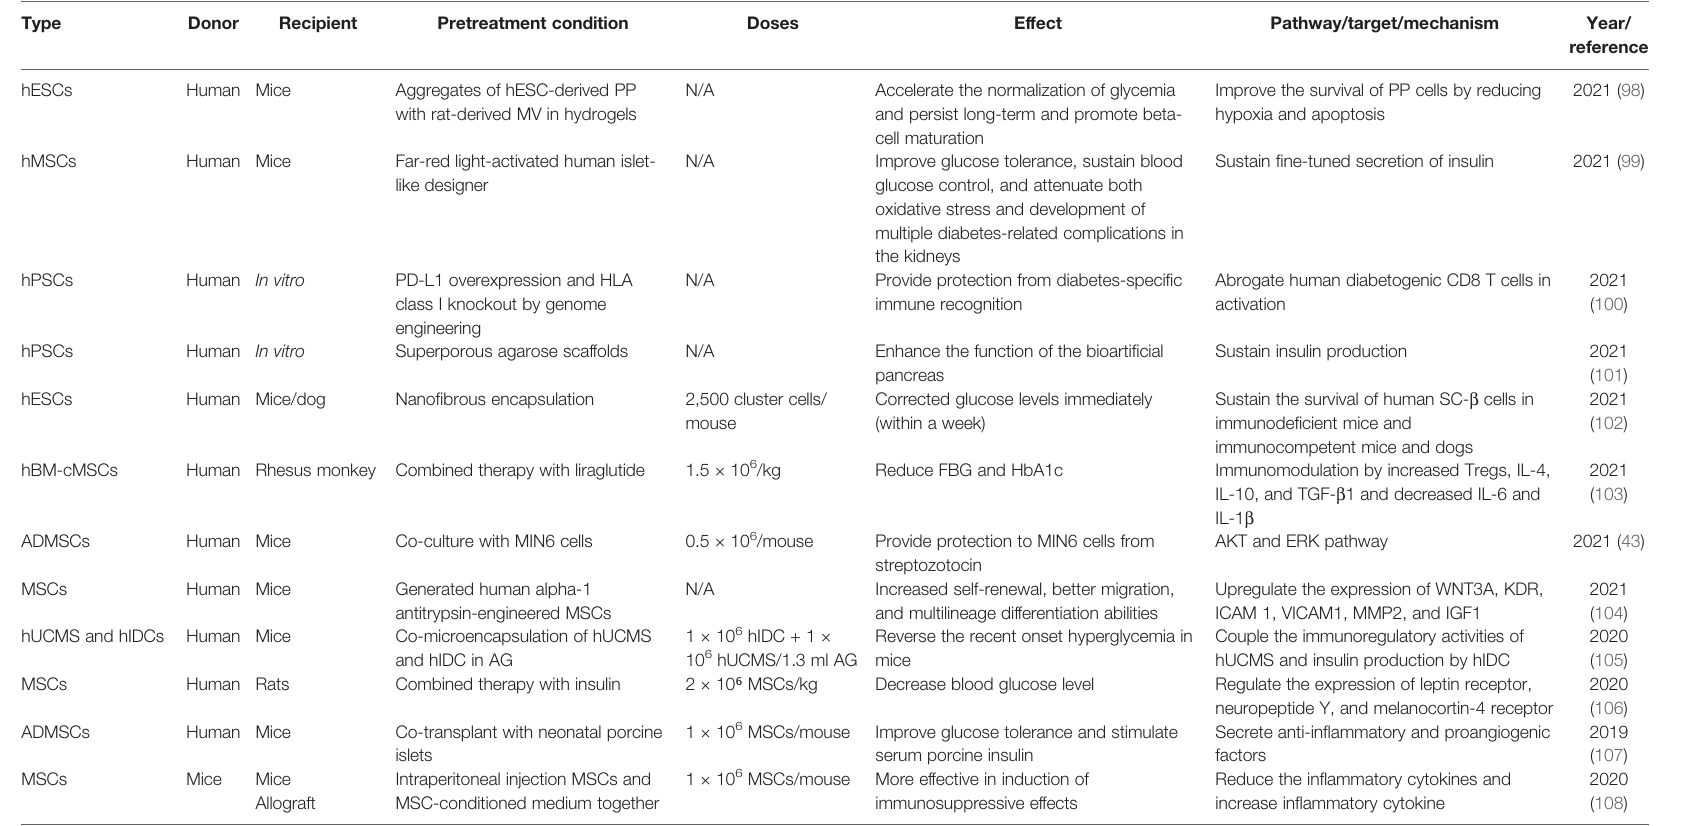
TABLE 1 | Intervention strategies to improve the treatment effect of stem